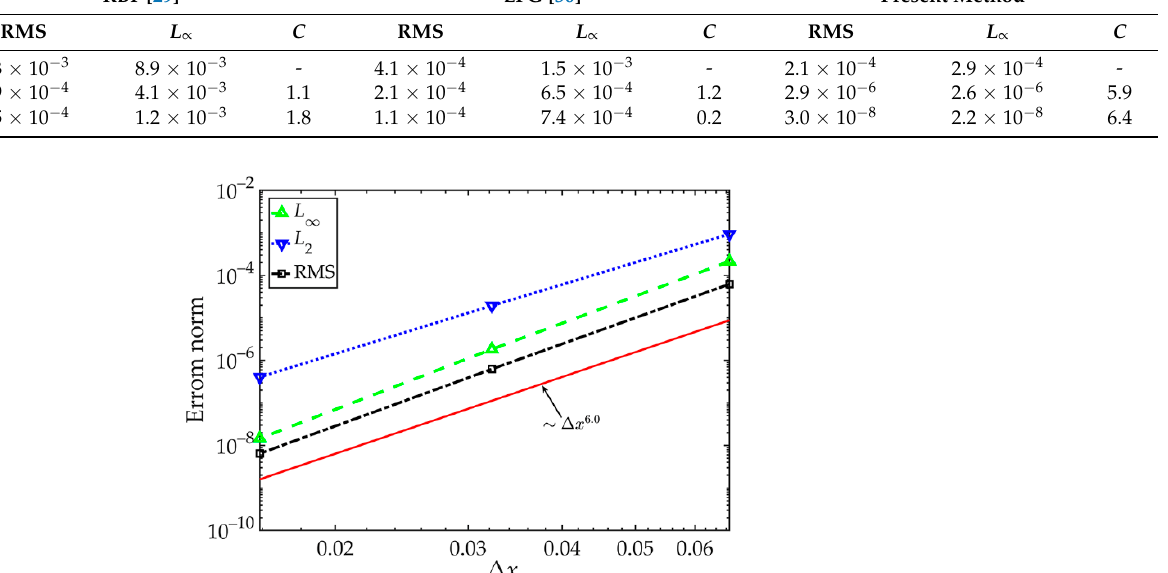
Figure 9. Error norms of the present wavelet solution at t = 1/2 as a function of Δ x for Example 4.